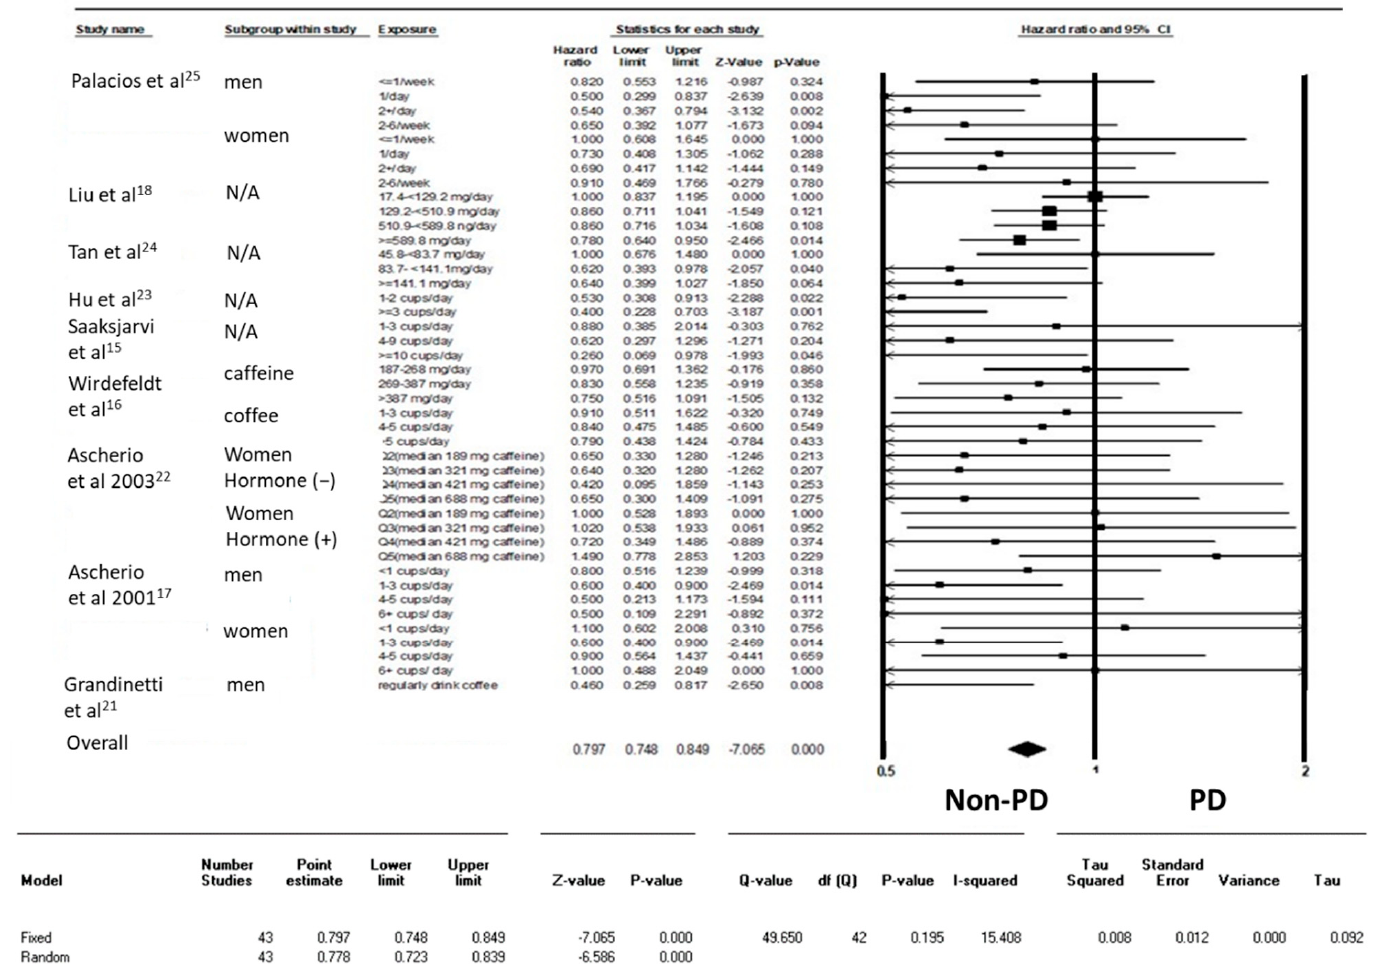
Figure 2. Forest plot illustrating the hazard ratio (HR) of Parkinson’s disease (PD) among healthy individuals from cohort studies.